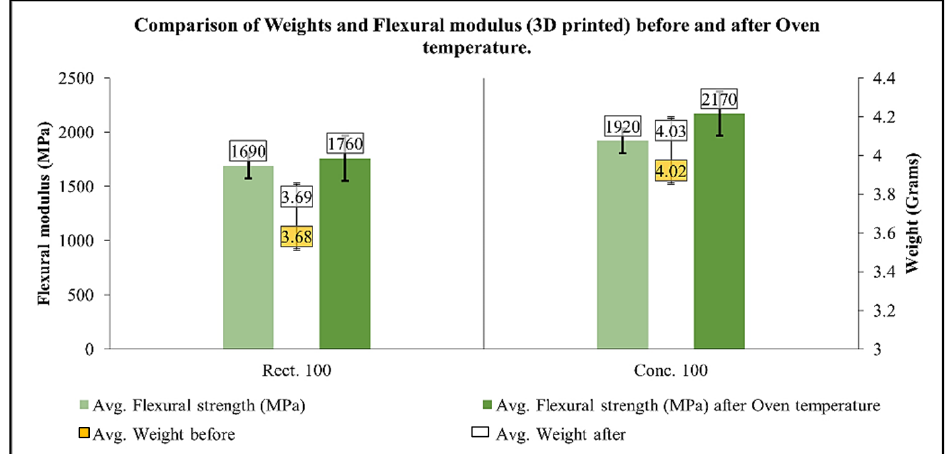
Figure 14. Comparison between weights and flexural modulus of PLA 3D-printed samples before and after oven temperature treatment.